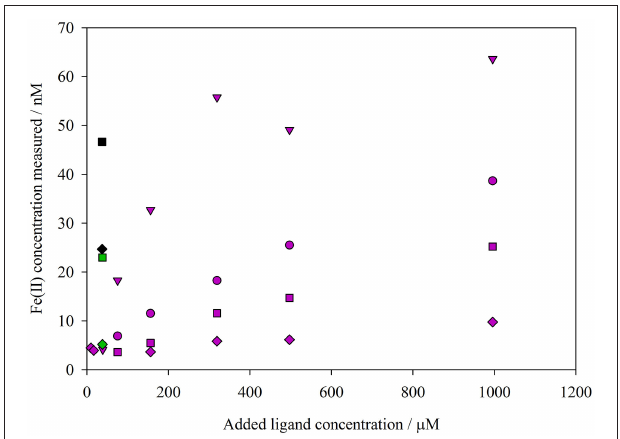
FIGURE 4 | The derivation of the pseudo-first order oxidation rate constant (k 1 ) from luminol A, luminol B, and ferrozine observed Fe(II) concentrations in method comparison experiment